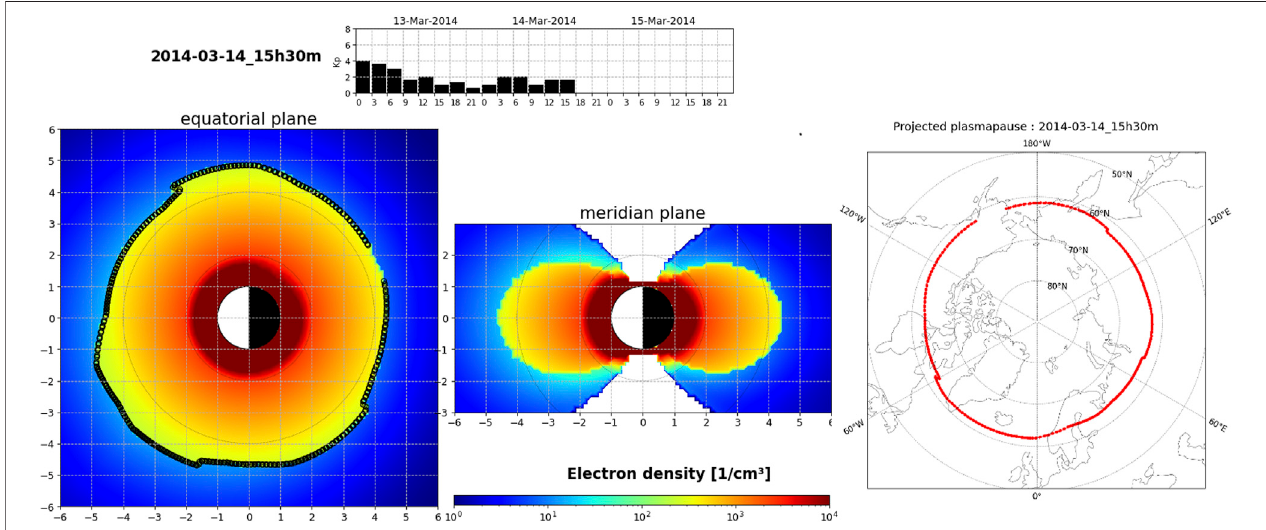
FIGURE4| TheelectrondensityoftheplasmasphereobtainedwiththeSPMmodelonMarch14,2014at15 h30UTinthe (left) equatorialand (middle) meridian plane. The right panel illustrates the footprint of the plasmapause projected at high latitude in the Northern ionosphere. The top panel shows the geomagnetic activity index Kp observed from 13 to March 15,